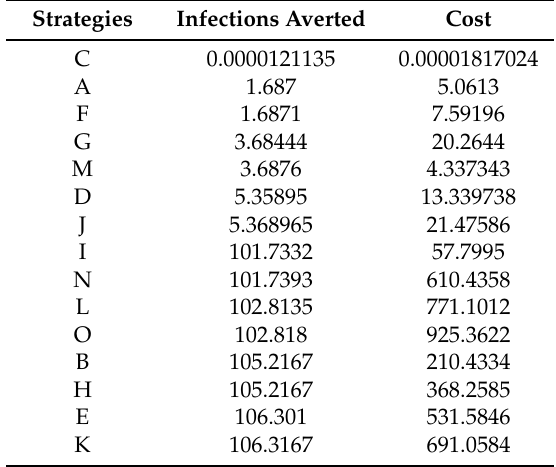
Table 6. Intervention strategies and its corresponding infections averted plus cost for Endemic